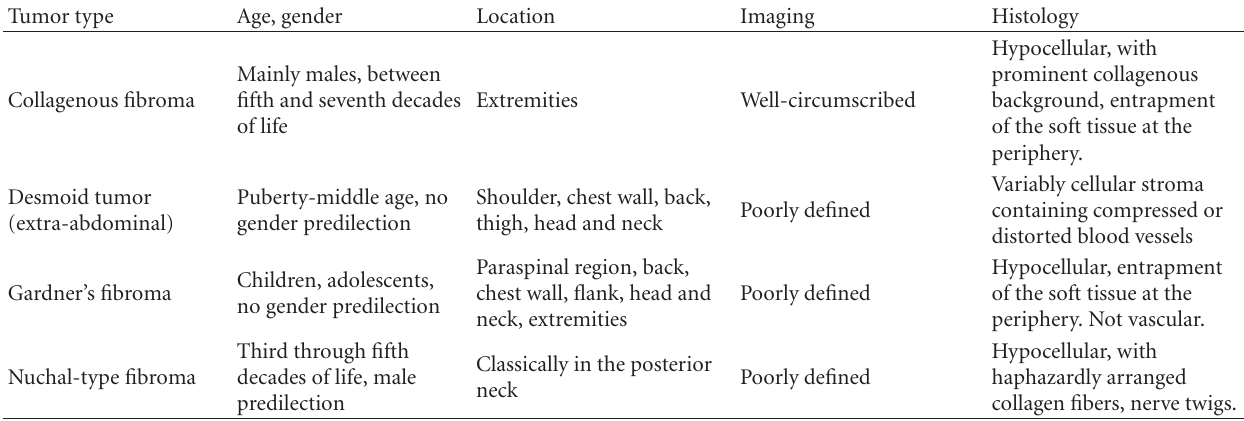
Table 1: Summary of the clinical, radiographic, and pathological characteristics of the tumors in the di ff erential for collagenous fibroma. Tumor